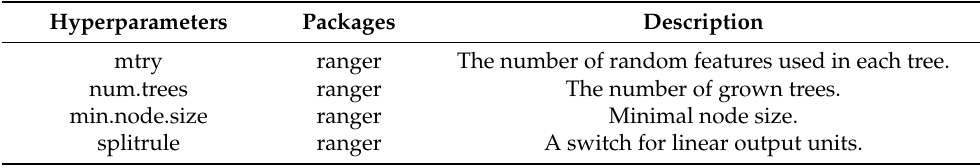
Table 3. RF and QRF